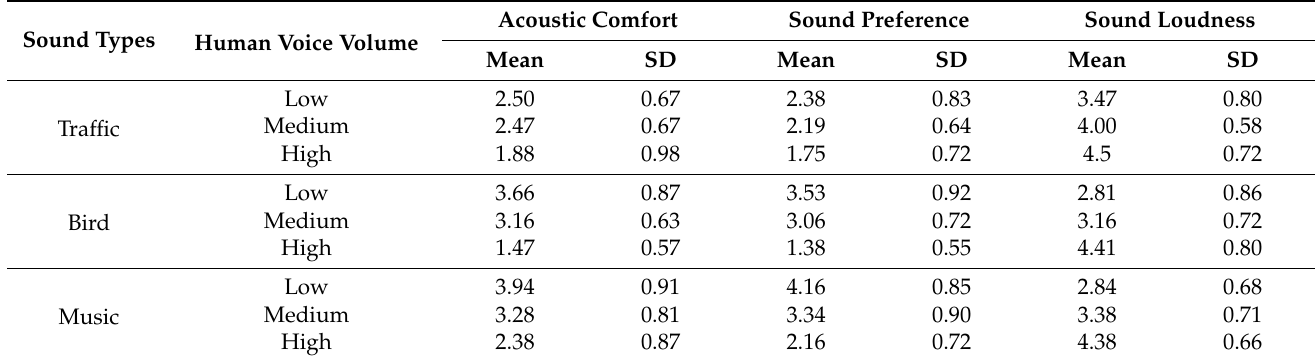
Table 1. Acoustic evaluation.